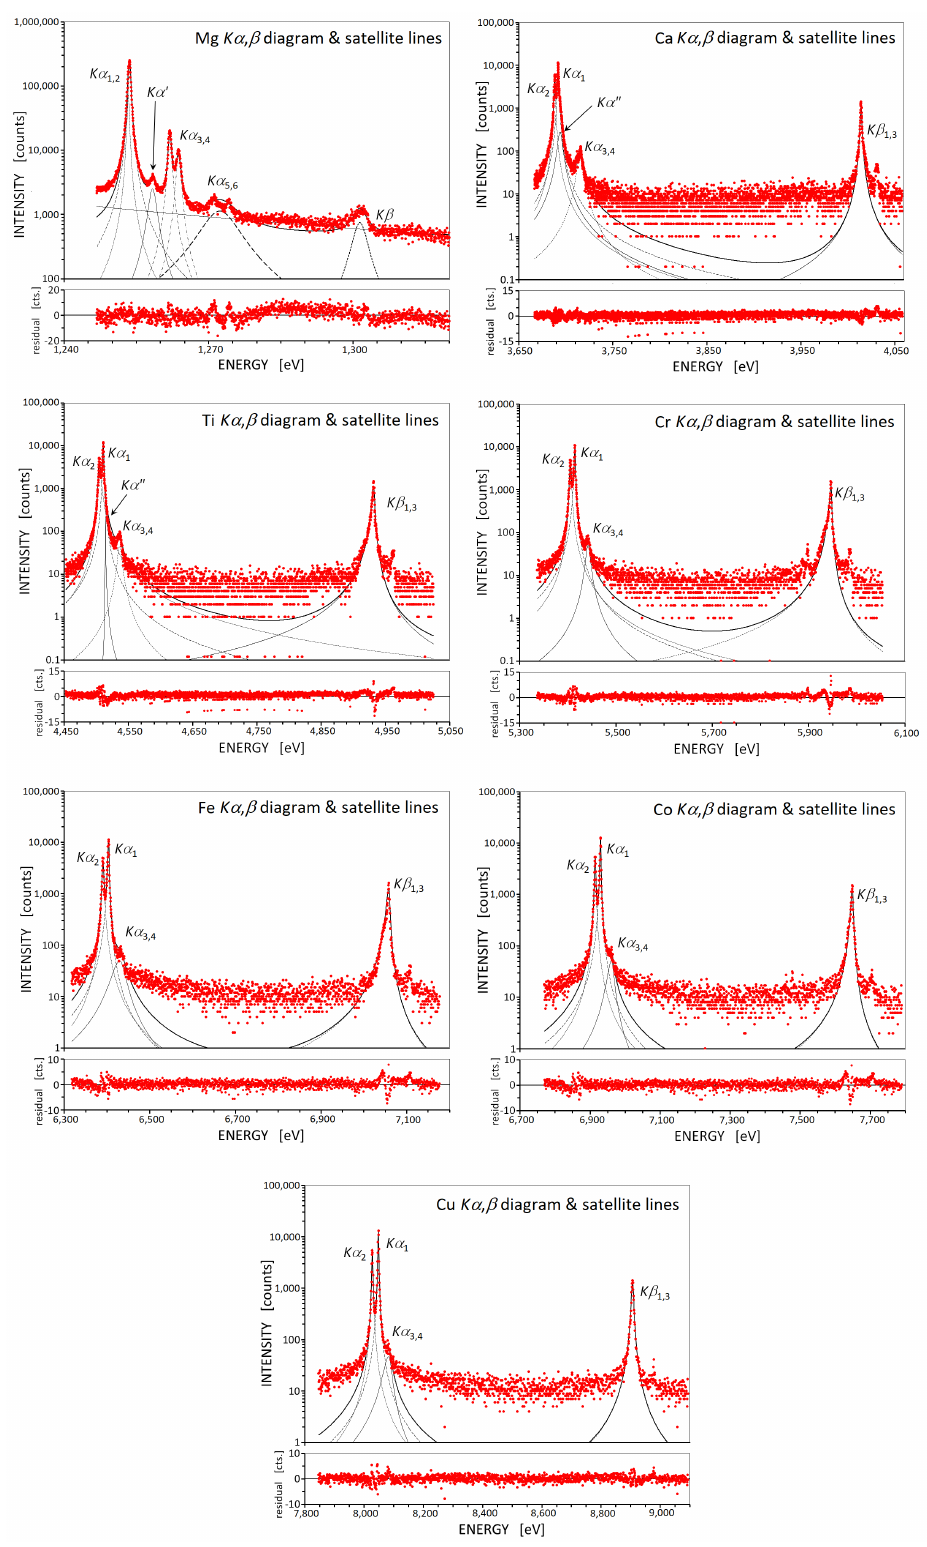
Figure 1. Some (Mg, Ca, Ti, Cr, Fe, Co, and Cu) of the observed K α , β emission spectra for elements Mg to Cu are shown. The fitting analyses using asymmetric Lorentz functions were performed for elements from Sc to Cu to obtain the K β / K α intensity ratio. For the other elements, symmetric Lorentz function fitting analyses were performed. Visible satellite lines K α (cid:48)(cid:48) , K α 3,4 , and K α 5,6 appear due to shake processes. Note the log scale in the vertical